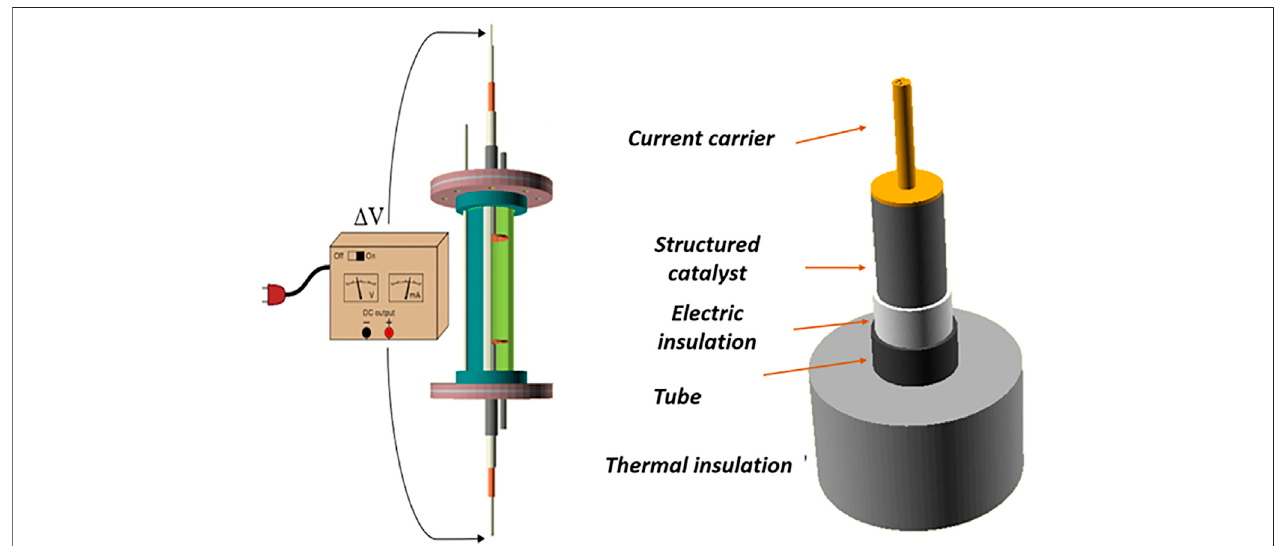
FIGURE 1 | Sketch of the reactor considered for the numerical